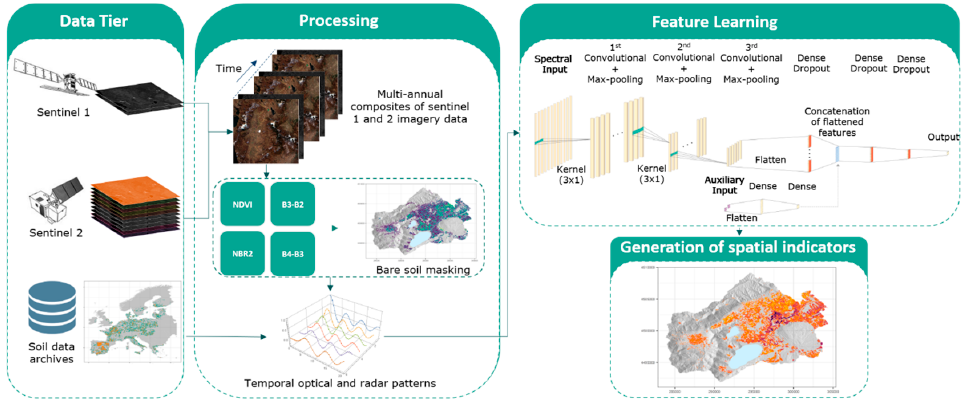
Figure 1. Flowchart of the proposed sentinel based soil monitoring scheme